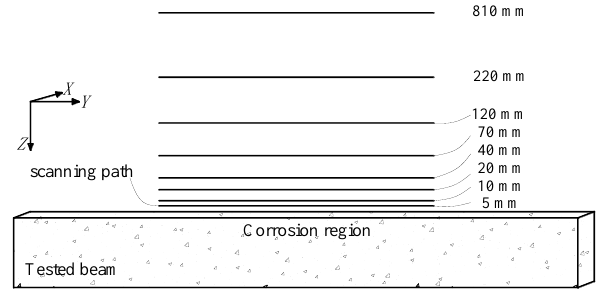
Figure 4. The scanning path of the tested beams to acquire self-magnetic flux leakage (SMFL) signals.